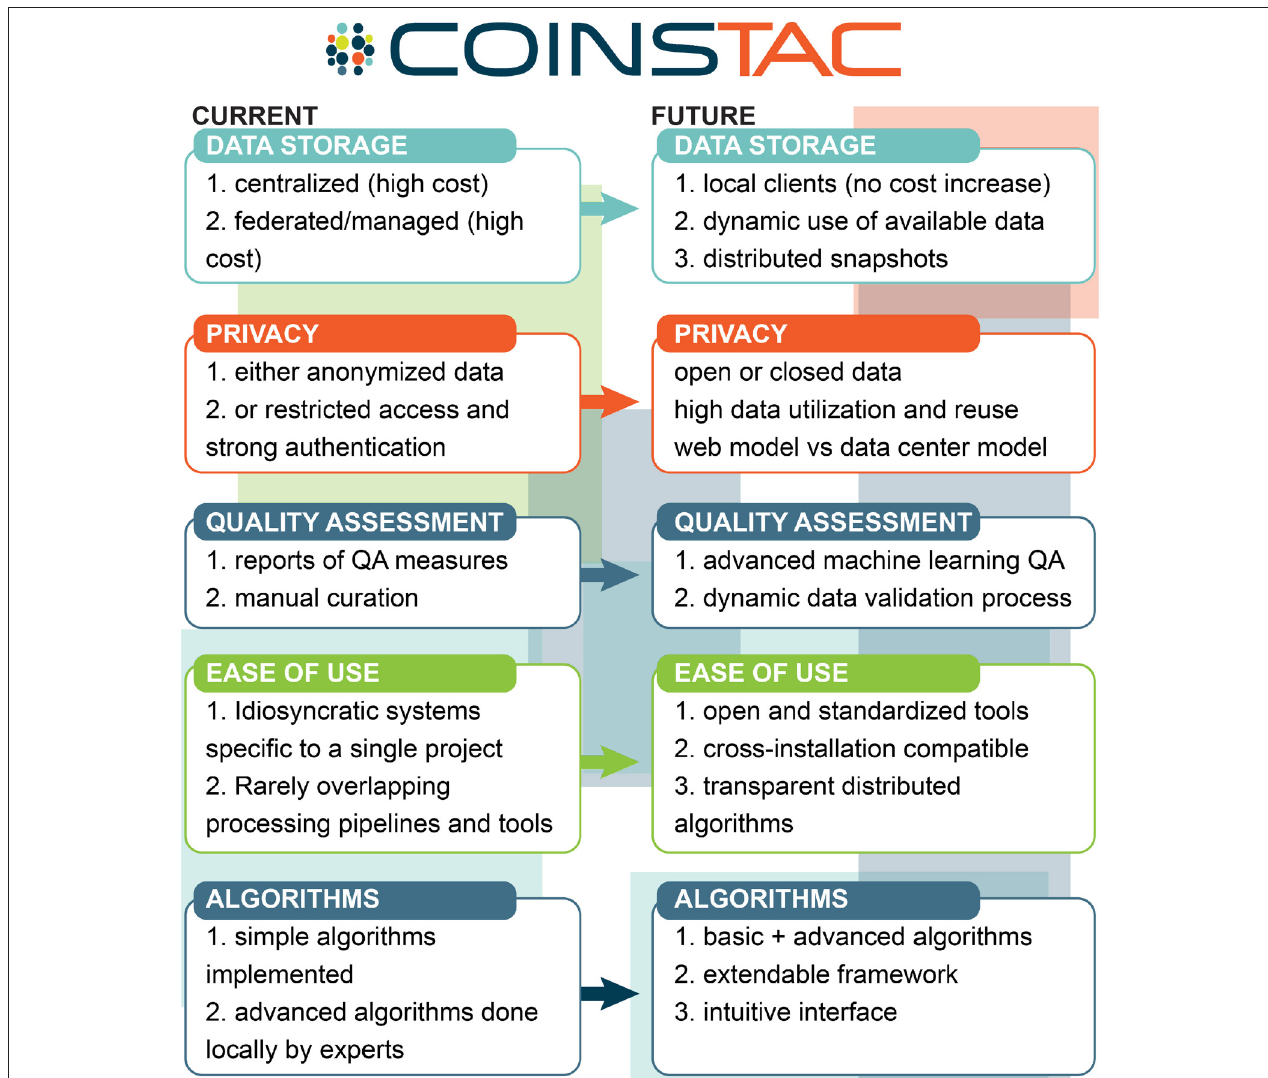
FIGURE 2 | COINSTAC vision for multisite data analysis relative to the current most common